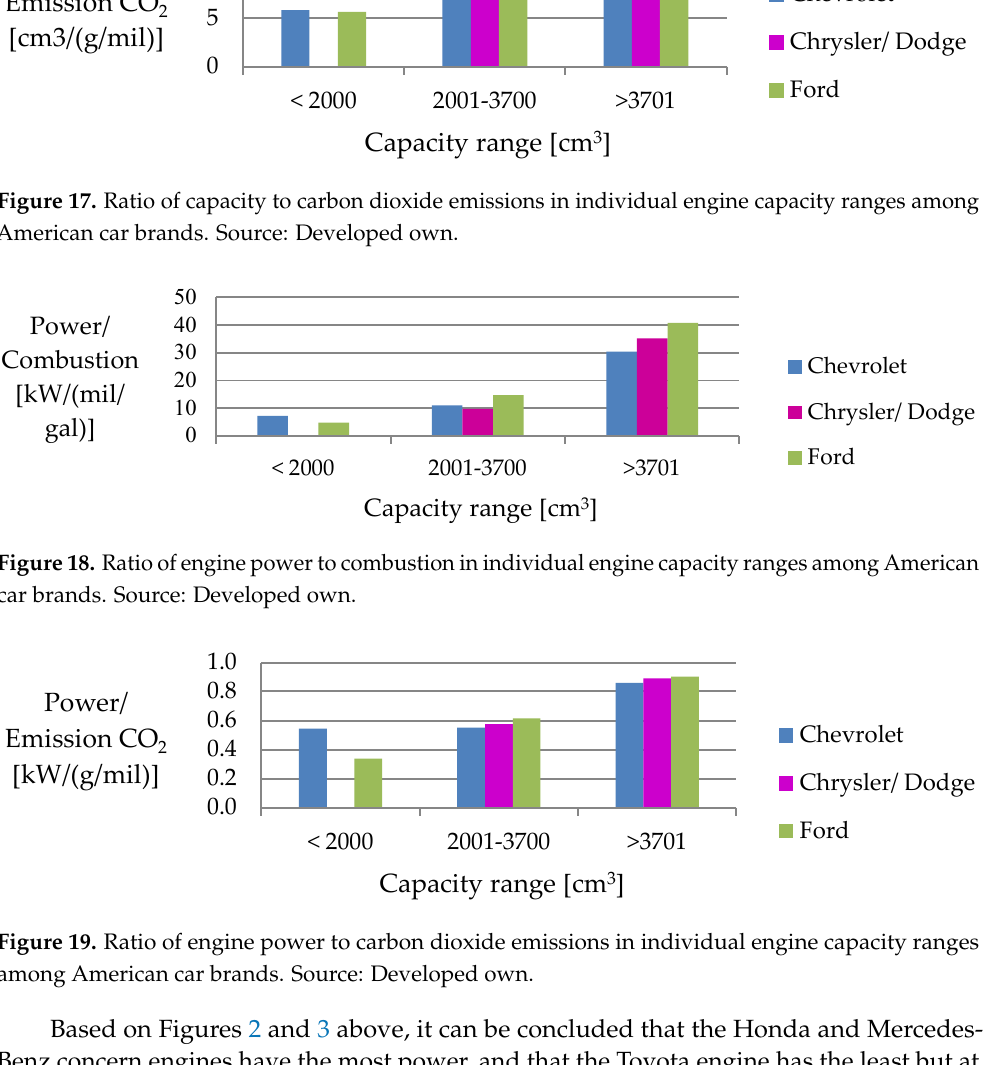
Figure 19. Ratio of engine power to carbon dioxide emissions in individual engine capacity ranges among American car brands. Source: Developed own.